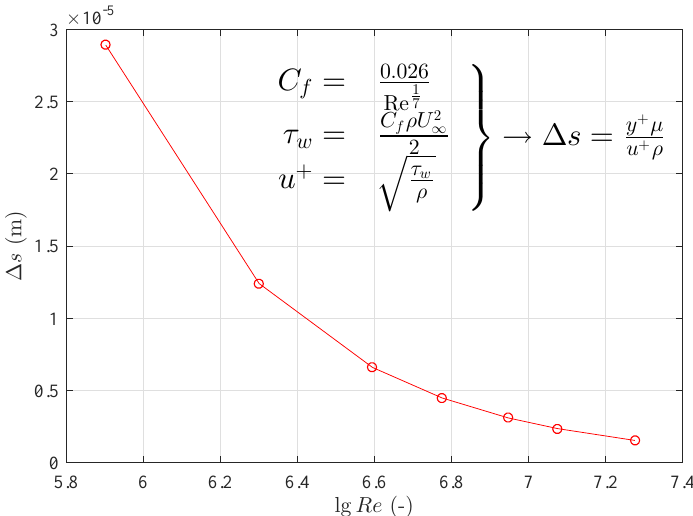
Figure 8. Different meshes’ height of first layer with varying Re and y + =